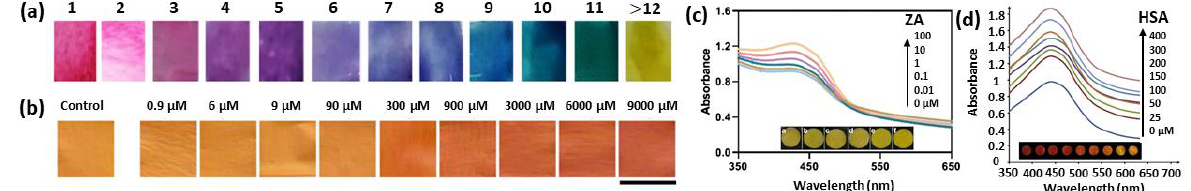
Figure 8. ( a ) Color scheme of the dyed RC/Cs-ESNW nanofiber mats, which developed different colors upon pH changes (pH 1–14), indicating that the color-changing ability of RC extract is re- tained after immobilization in the electrospun non-woven cellulose fiber (Cs-ESNW) matrix [144]. ( b ) Scanned images of the curcumin-embedded BC strip in the absence (control) and in the presence of different concentrations of Pb 2+ ions (Scale bar: 0.5 cm) [146]. ( c ) Changes in absorption intensities and color (insert) of the curcumin-doped BC nano-paper coupled with Fe(III) ions (100 µ M) at 427 nm with various concentrations of zoledronic acid (ZA) [147]. ( d ) UV-vis absorption spectra and photographical images (insert) of the curcumin-embedded BC nano-paper with various concentra- tions of HSA in the range of 0 to 400 mM [148]. Copyrights: all images have been adapted and re- produced with permission from: ( a ) © 2014 Elsevier B.V.; ( b ) © 2021, Iranian Chemical Society; ( c ) © 2019, Springer-Verlag GmbH Austria, part of Springer Nature; ( d ) © 2019 Elsevier B.V.